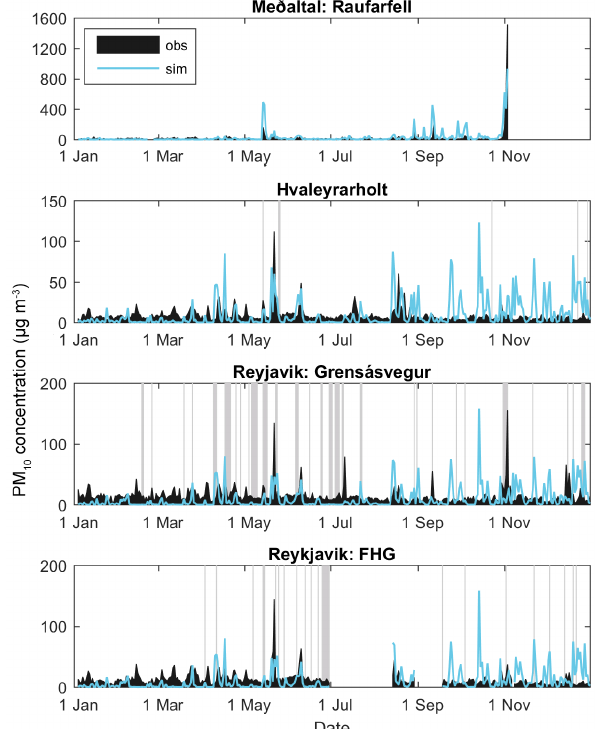
Figure 2. Daily mean PM 10 concentrations (µgm − 3 ) as observed (black) and modelled (blue) in 2012. A simulation where a time lag after precipitation was taken into account is shown at Raufarfell (Test_P, orange). Shaded grey areas indicate periods with inconsis- tent measurements of PM 10 and PM 2 . 5 (also see Fig. 3).